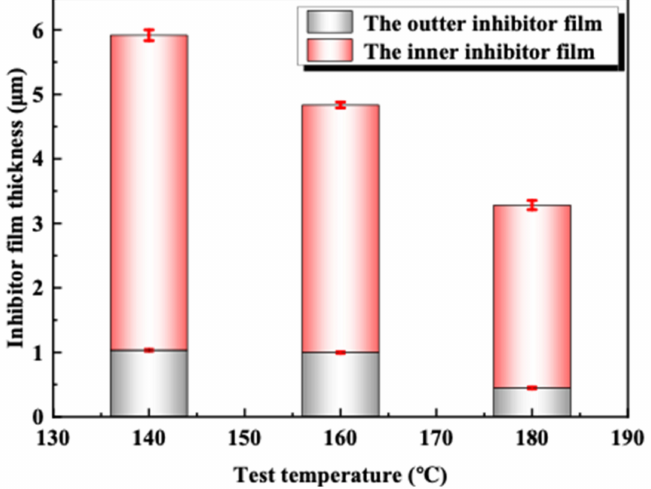
Figure 6. Thickness of corrosion inhibitor film on 2205 duplex stainless steel at different